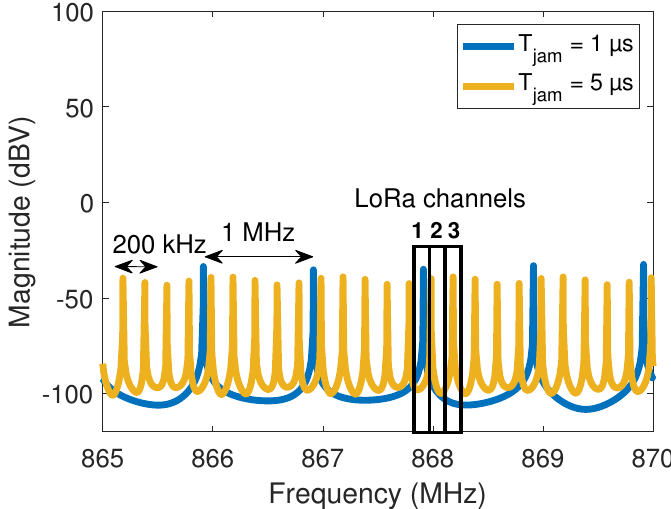
Figure 5. Jamming signal spectra (T jam = 1µs, T jam = 5µs and amplitude equal to 250 mV) seen through a 1.024ms window of a LoRa demodulator (SF = 7). The spectrum spans from 840 MHz